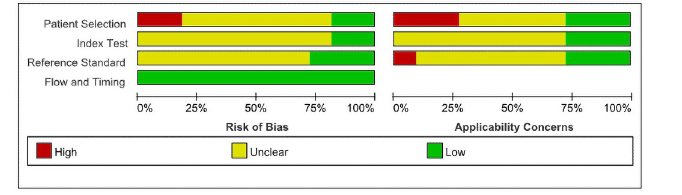
Fig 2. Risk of bias and applicability